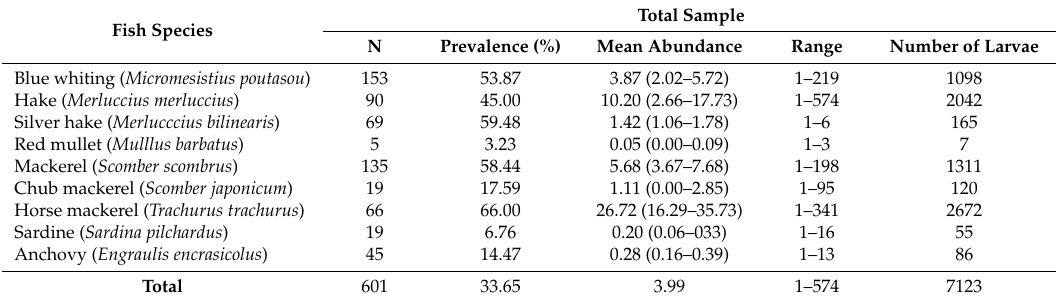
Table 1. Prevalence (%), mean abundance and 95% confidence intervals, intensity range (minimum-maximum) and number of Anisakis type I larvae in the total sample.